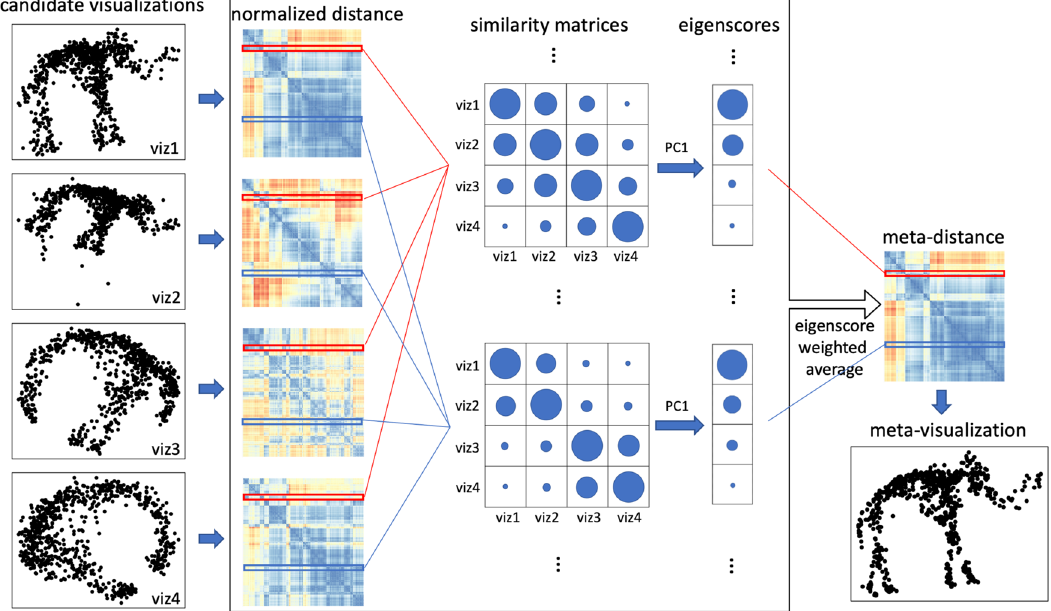
Fig. 1 | A graphical illustration of the proposed method. The algorithm takes as input the normalized pairwise distance matrices associated to a collection of can- didate visualizations (viz1 to viz4) of a dataset. For each sample of the dataset, we compute the similarity matrix between the rows of the normalized distance matrices associated to the sample (rows highlighted in the same color), and then de fi ne the corresponding eigenscores as the fi rst eigenvector of the similarity